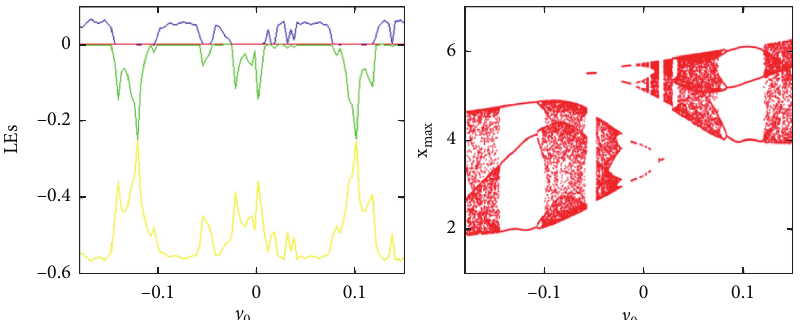
Figure 11: Dynamical evolution of system (1) with (a) � 0.8, (b) � 0.5, (c) � 1, (d) � 0.1 and initial condition IC � (0.01, y in [-0.18, 0.15]: (a) Lyapunov exponent spectrum and (b) bifurcation.